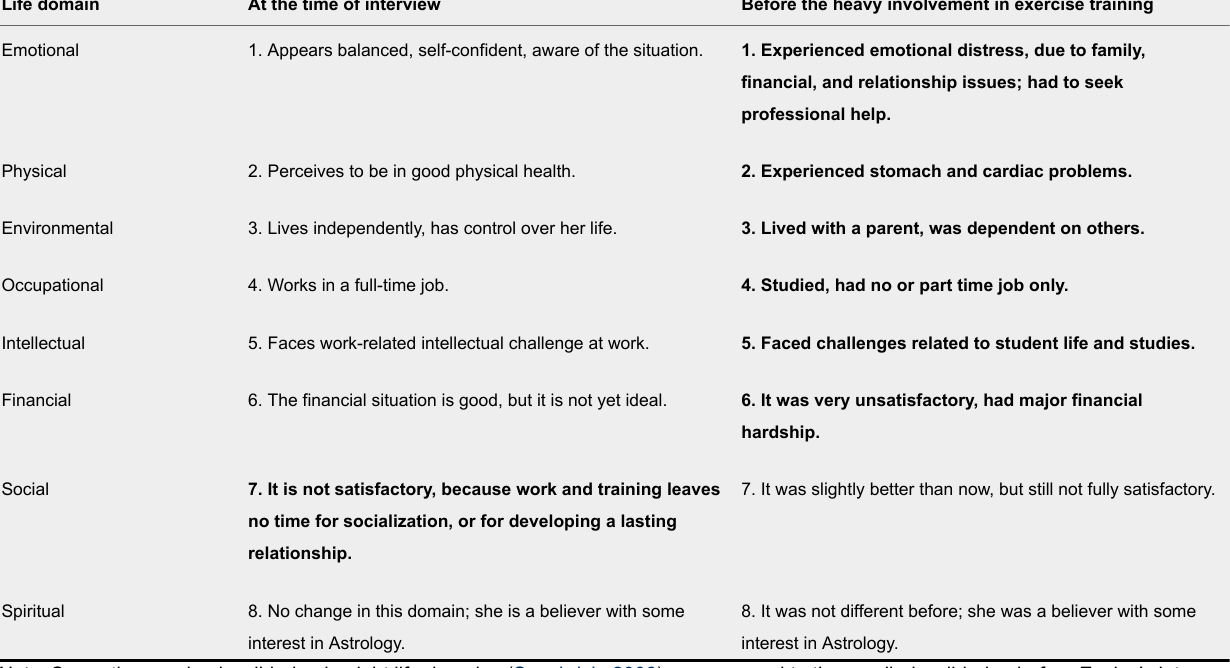
Perceived Well-Being in Eight Life